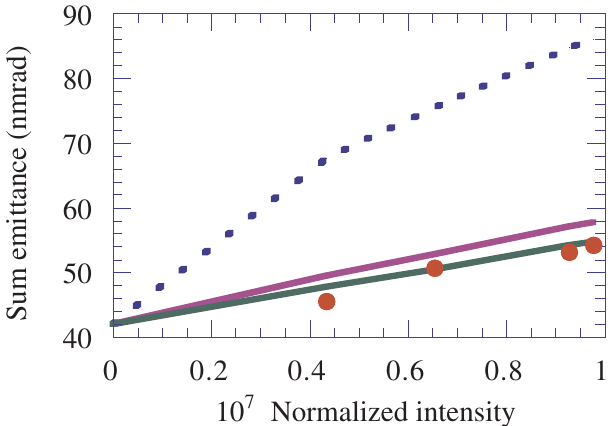
FIG. 13. (Color) Sum of the emittances estimated from the beam-beam tune shift (red dots) and calculated sum emittance with a horizontal tune of 0.512 (blue dashed line), of 0.540 (purple solid line) and of 0.550 (green solid line) as a function of the normalized